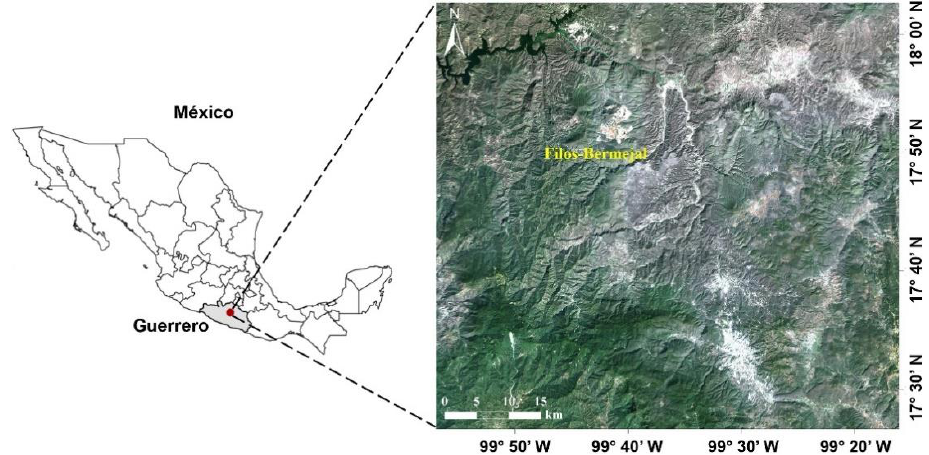
Figure 1. Study area: The central zone of Guerrero State in Mexico.